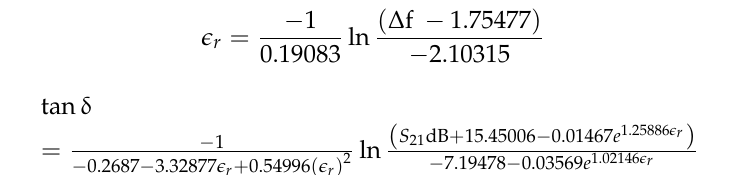
Figure 3. ( a ) Front and back picture of the fabricated sensor. ( b ) Experimental set ‐ up used for oil